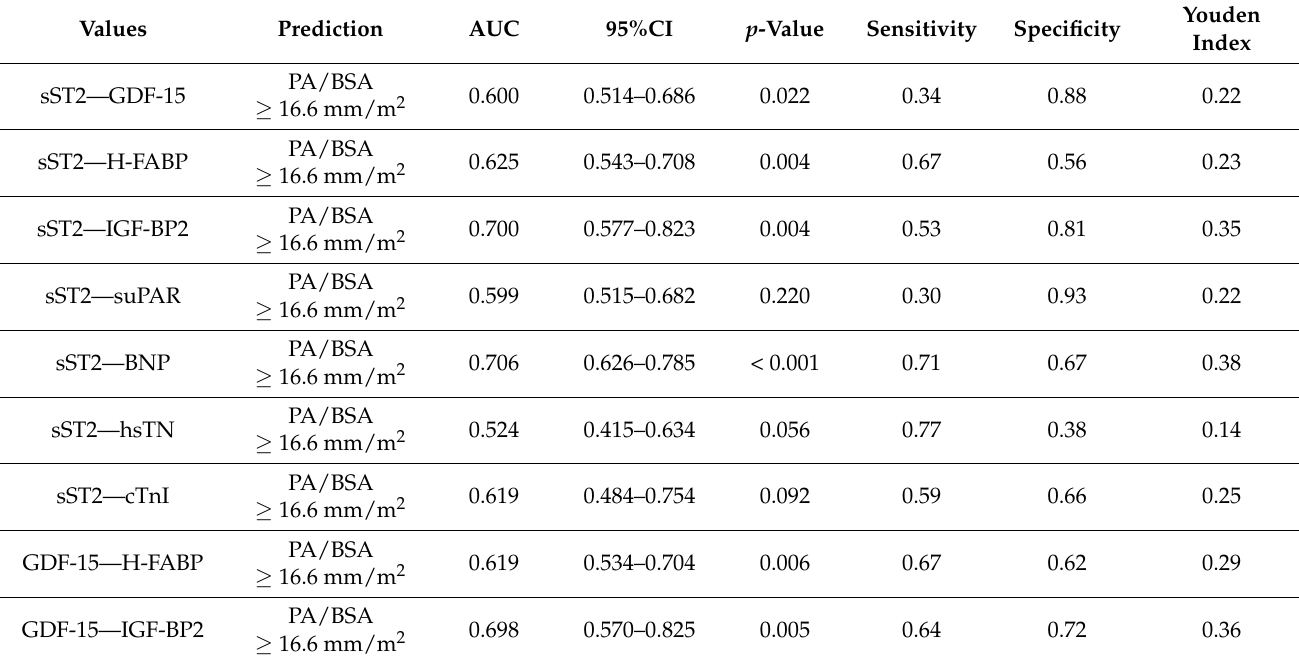
Table 5. Tabular overview of AUROC analyses of a combination of 2 biomarkers for prediction of a PA/BSA value ≥ 16.6 mm/m 2 with concerning Youden Index, sensitivity, and